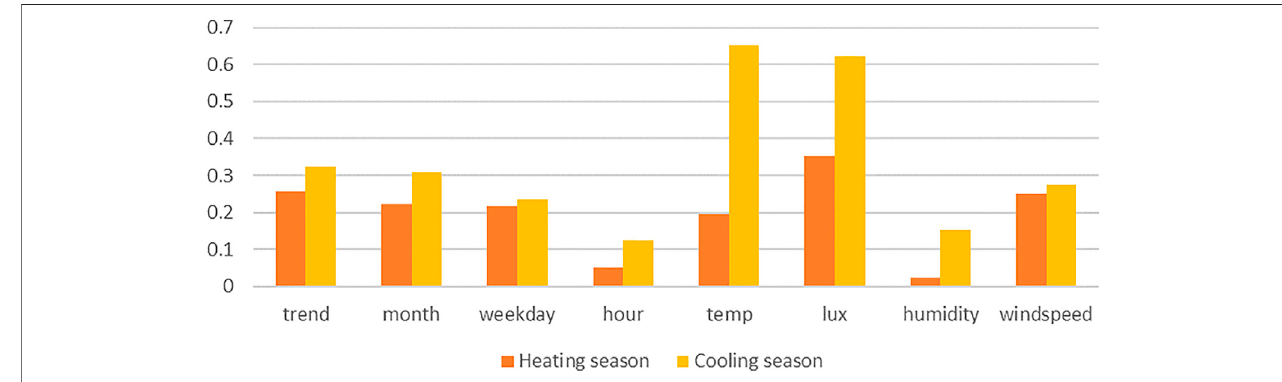
FIGURE 9 | Absolute value of correlation coef fi cients of load and other features in the database between heating season and cooling season.